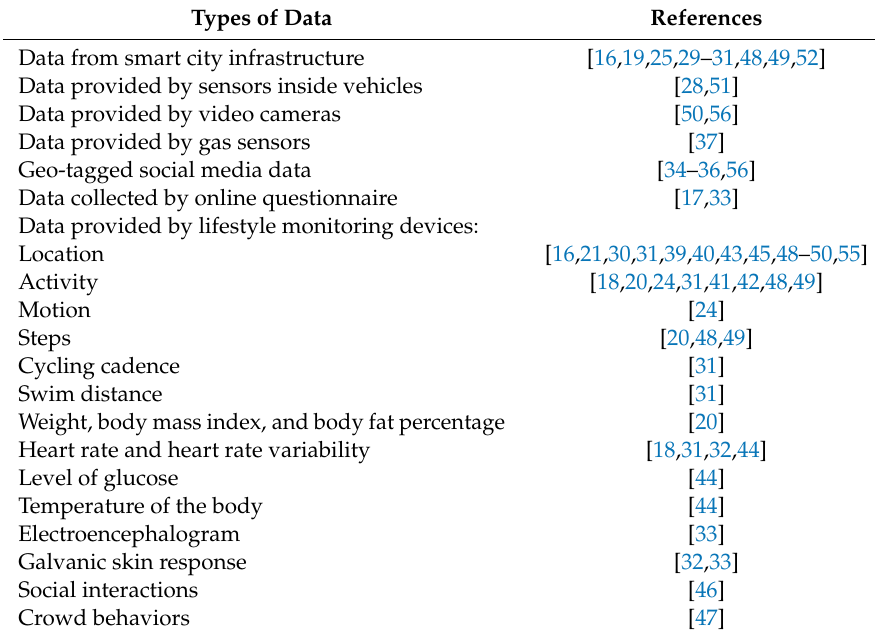
Table 1. Types of data being